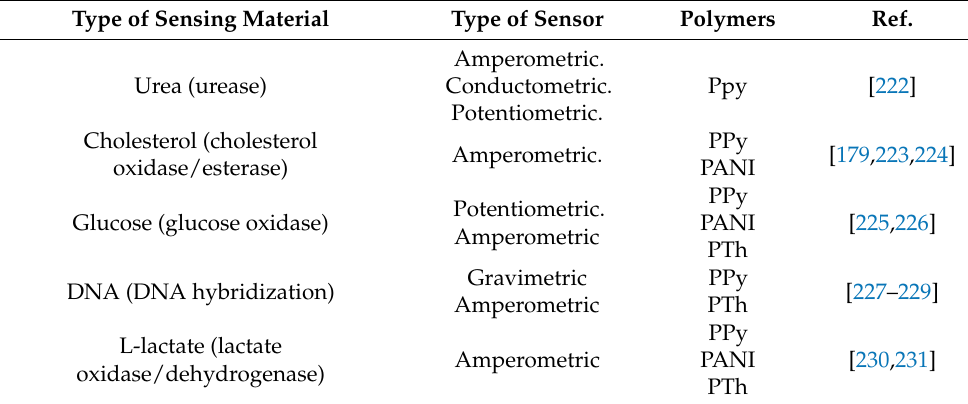
Table 5. Various types of biosensors utilizing conductive polymers. Type of Sensing